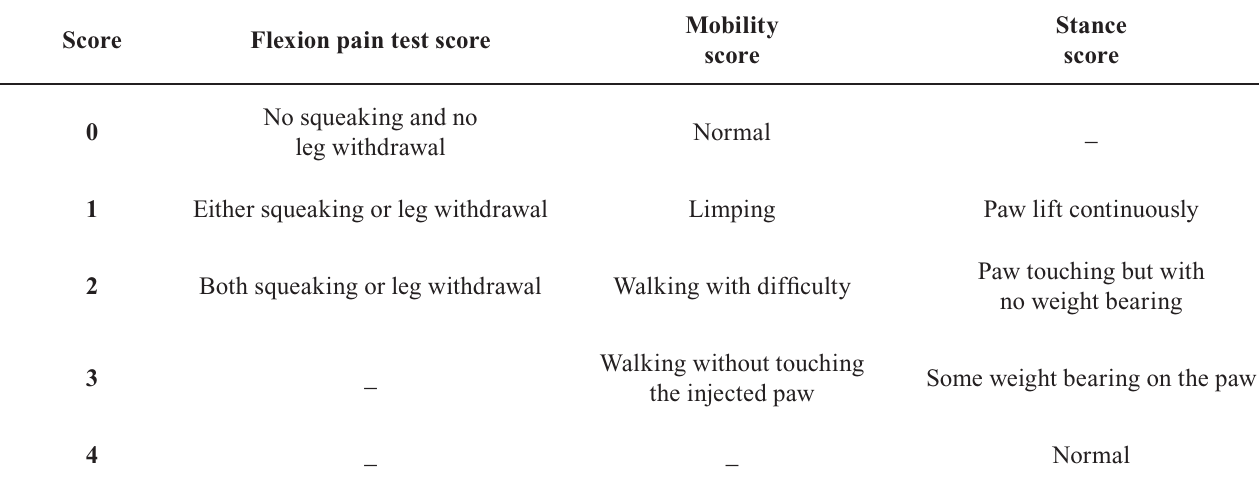
TABLE I- Sc oring system for evaluation of the pain associated with FCA induced arthritic